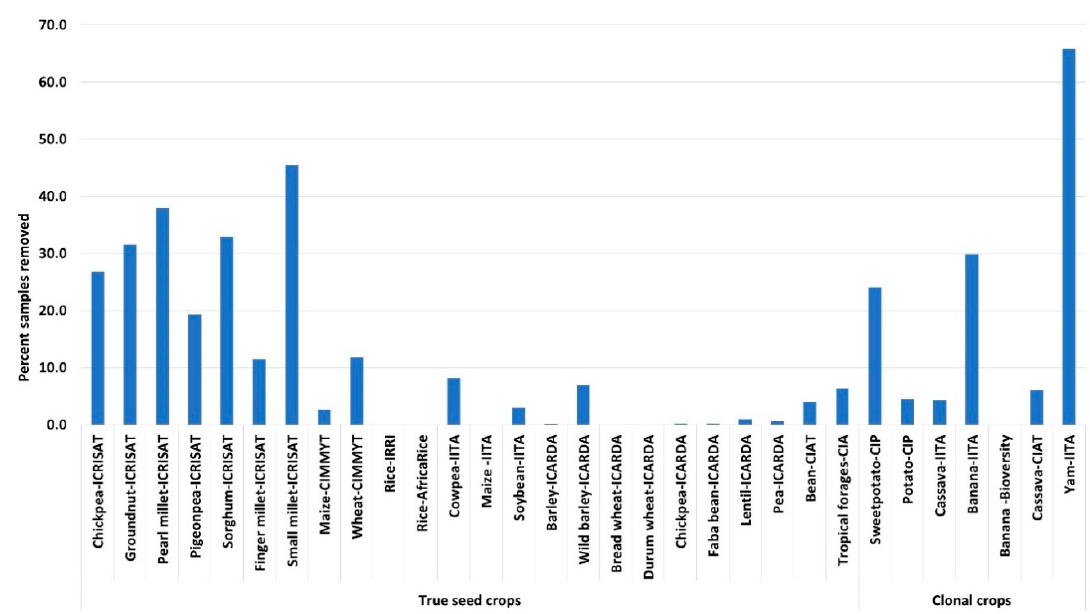
Figure 5. Percentages of samples removed, due to pest interception during phytosanitary processing.